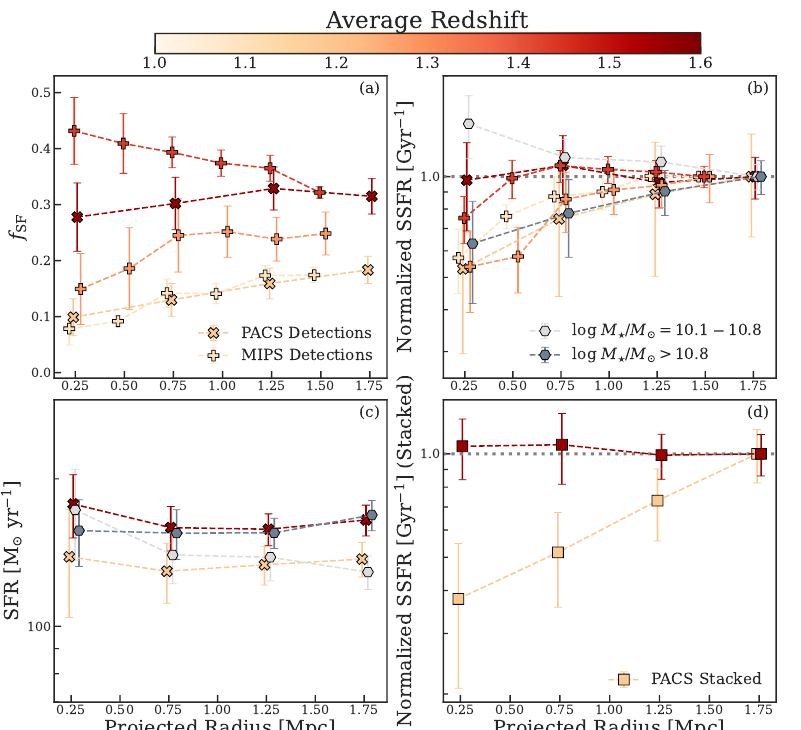
Figure 9. Star formation properties of ISCS/IDCS cluster galaxies at z > 1 as a function of projected, cluster-centric radius. ( a ) The star-forming fraction for MIPS- [175] and PACS-detected [523] popula- tions. By z ∼ 1.4, f SF is flat or even rising into the cluster cores. ( b ) The field-normalized SSFRs, where the field is taken from the largest radial bin. Light and dark gray hexagons show the PACS-detected sample divided into log M (cid:63) / M (cid:12) = 10.1–10.8 and log M (cid:63) / M (cid:12) > 10.8 bins, respectively, instead of redshift. The lower mass bin shows evidence of a rise in SSFR into the cores. ( c ) The average SFR of the PACS-detected sample, which show no radial trends. ( d ) Mass-limited cluster members stacked on PACS 100 µ m imaging. No radial trend is evident at z > 1.4, while a strong radial trend appears by z ∼